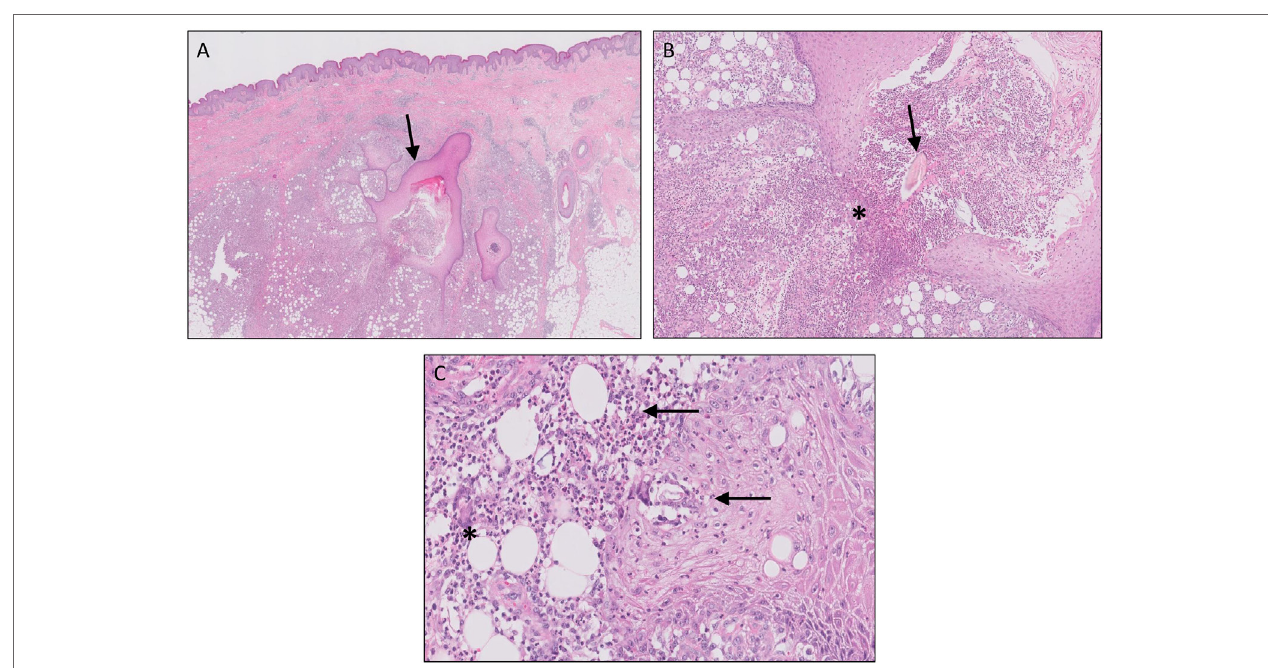
FigURe 3 | Hidradenitis suppurativa. Sinus tracts [ (A) , arrow], active inflammation, and rupture [ (B) , asterisks] of the follicular epithelium with “floating” hair fragments [ (B) , arrow]. Subsequently, a secondary inflammatory response is induced with influx of numerous neutrophils [ (C) , arrows] and granulomatous foreign body reaction with giant cells [ (C) ,